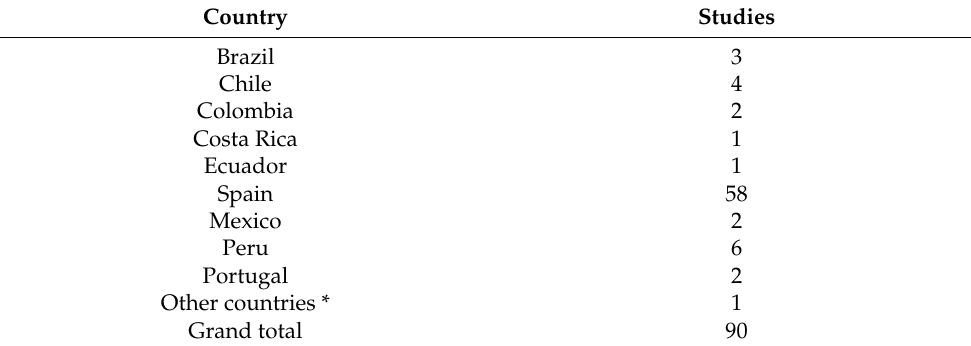
Table 3. Geographical distribution of the articles included.